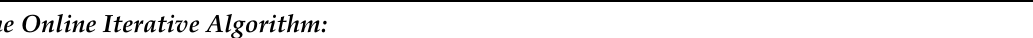
Figure 4. The lift force and the motor power dependences on the rotational speed and the propeller pitch. Therefore, the motor power consumption is approximately the lowest while changing the propeller pitch and the rotational speed according to Equation (15). Referring to Equation (16) and Figure 3, we then present the online iterative algorithm to optimize the propeller pitch command and the rotational speed command quickly: